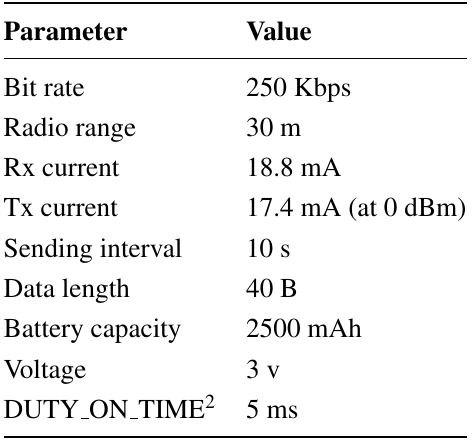
Table 2. Parameter values used in the simulations.